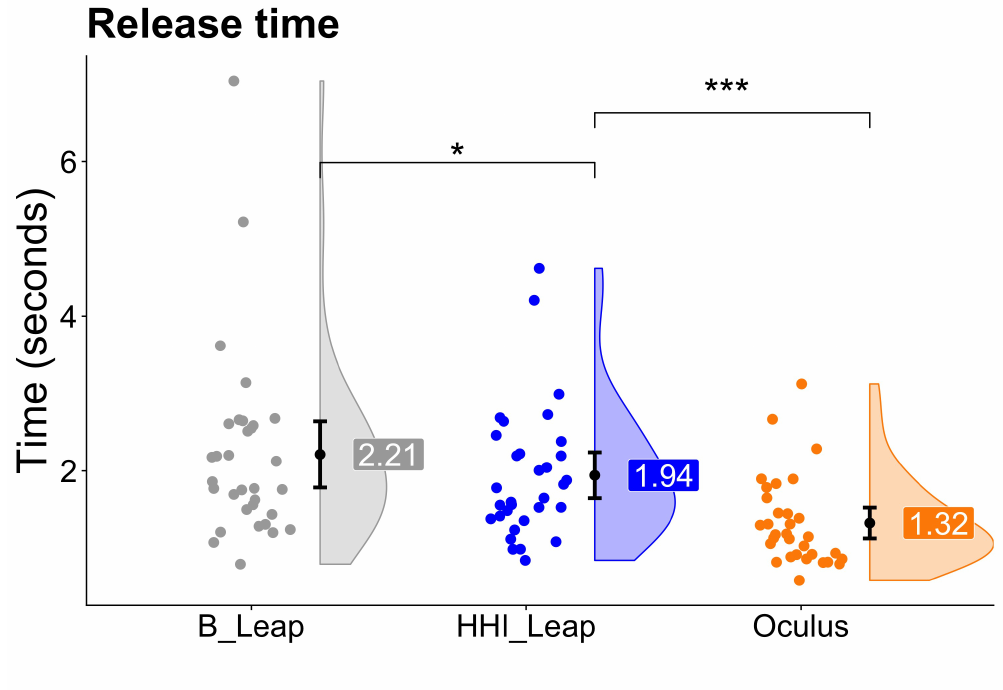
Figure 7. Release time by interface, with means and 95% confidence intervals, individual participant times (colored dots), smoothed density distributions and the results of paired-samples t -tests. * = p < 0.05, *** = p <